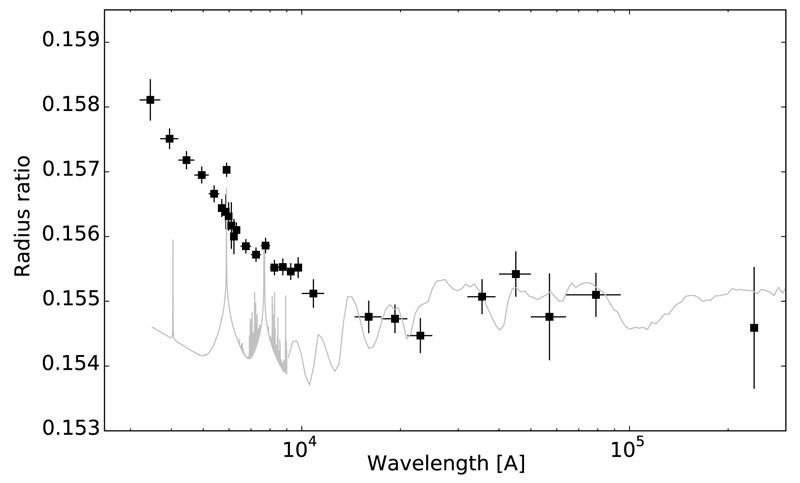
Transmission spectrum of the hot Jupiter HD 189733b from UV to near-infrared (from Pont et al. 2013). The black circles with error bars show the data available at that time, observed using multiple instruments on HST and Spitzer. The grey curve shows a model spectrum for a dust-free atmosphere. The steep blue-ward rise in the spectrum was indicative of strong scattering due to haze/dust in the atmosphere which was not consistent with the expected model spectrum for a haze-free atmosphere